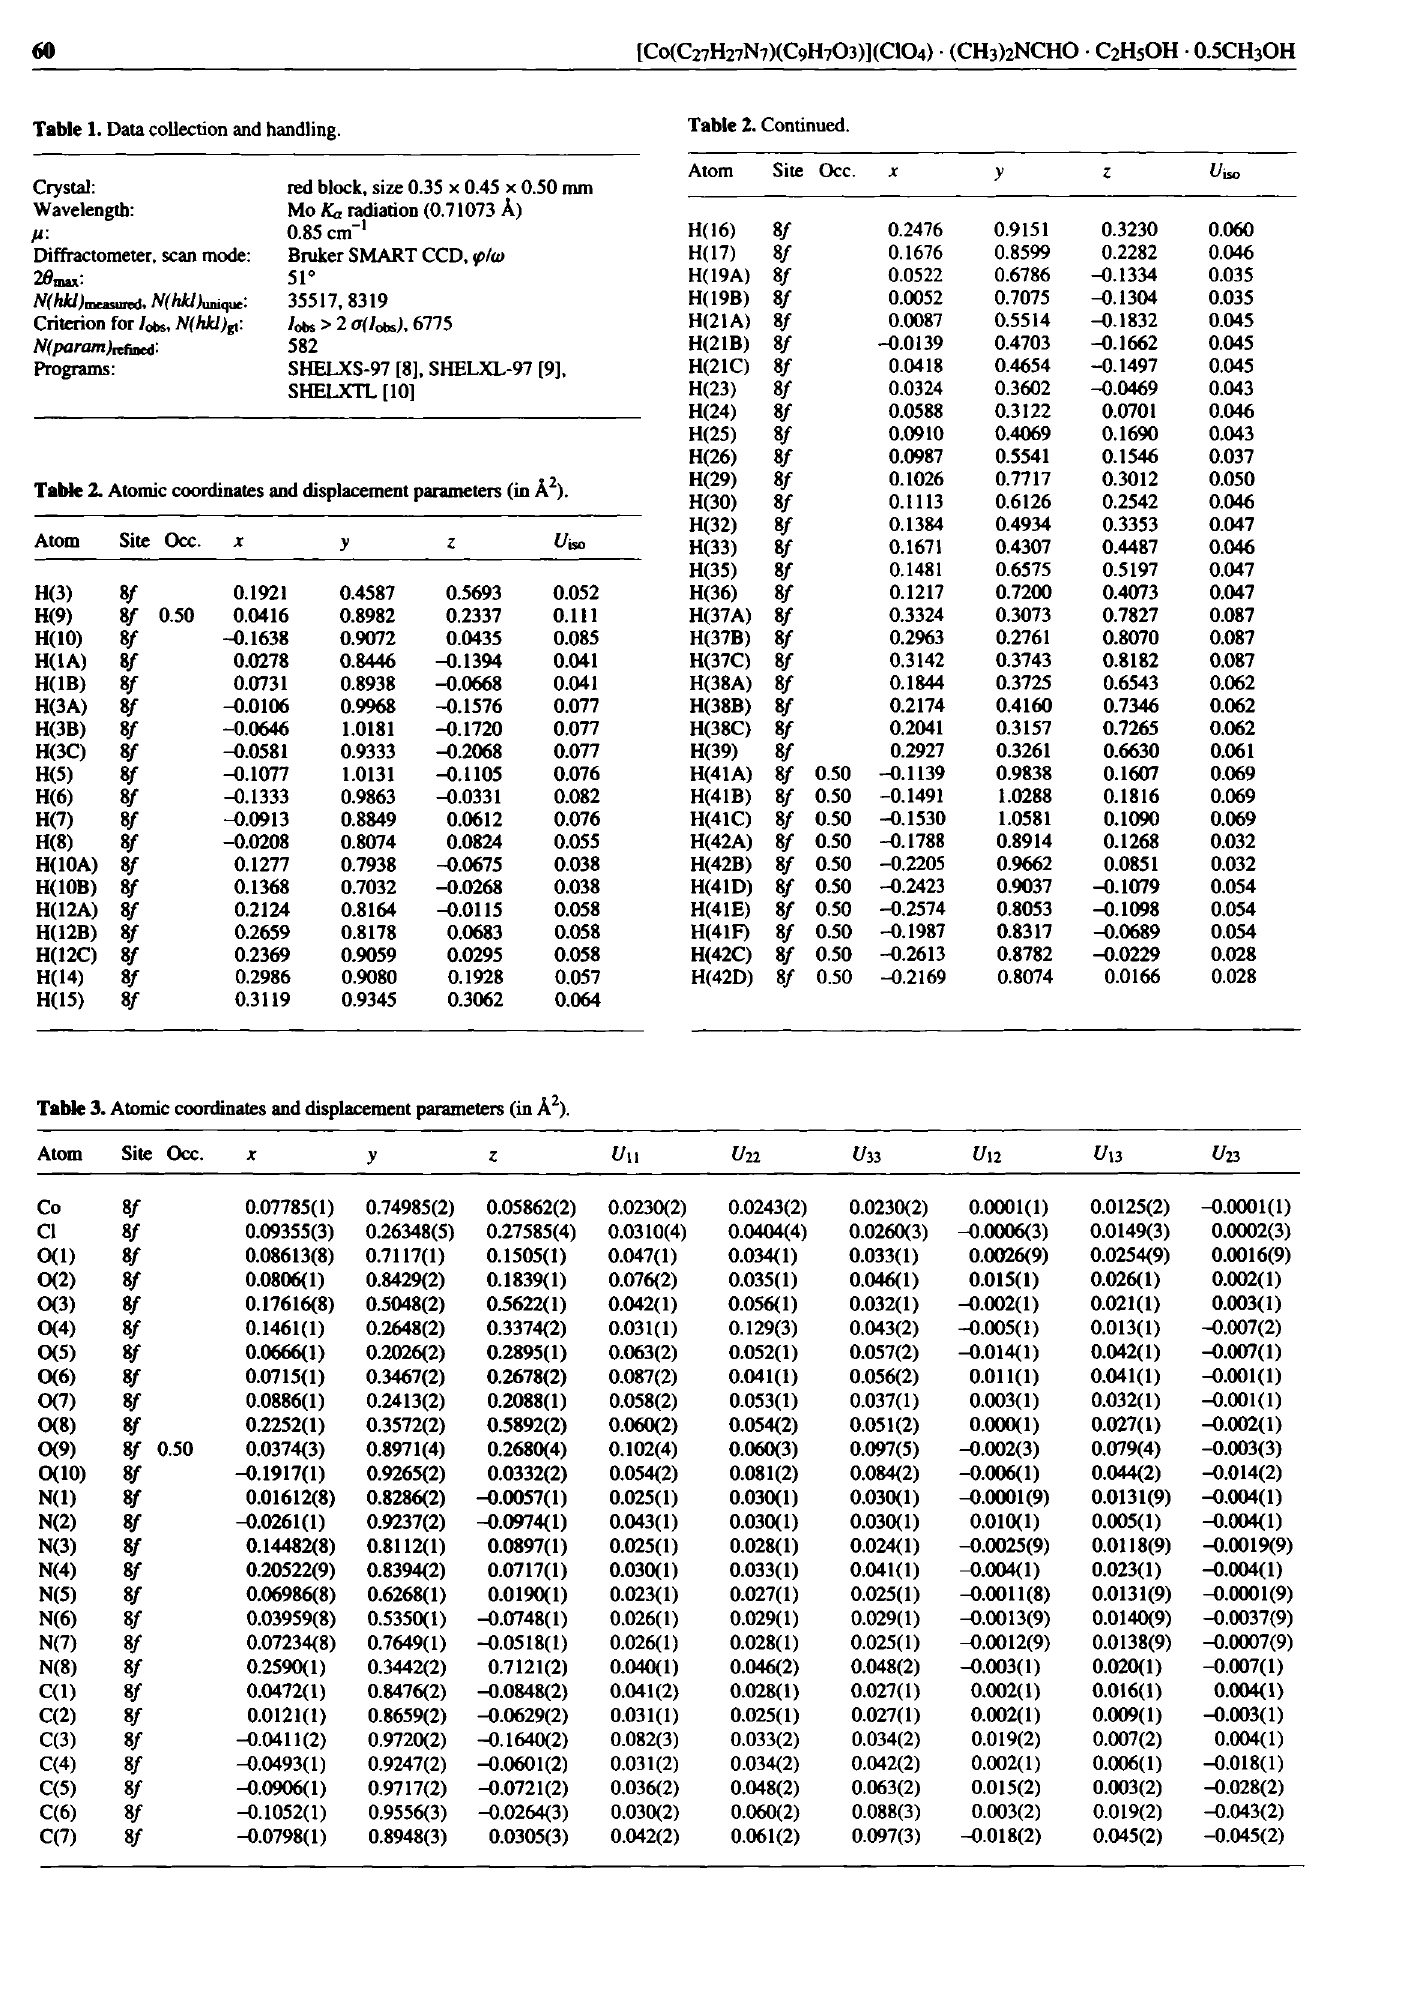
Table 1. Data collection and handling. Table 2. Continued.